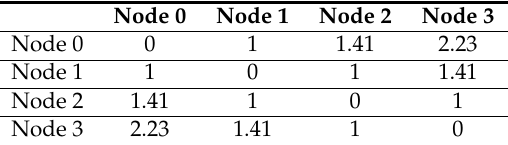
Table 3. The cost matrix for the network G 1 .